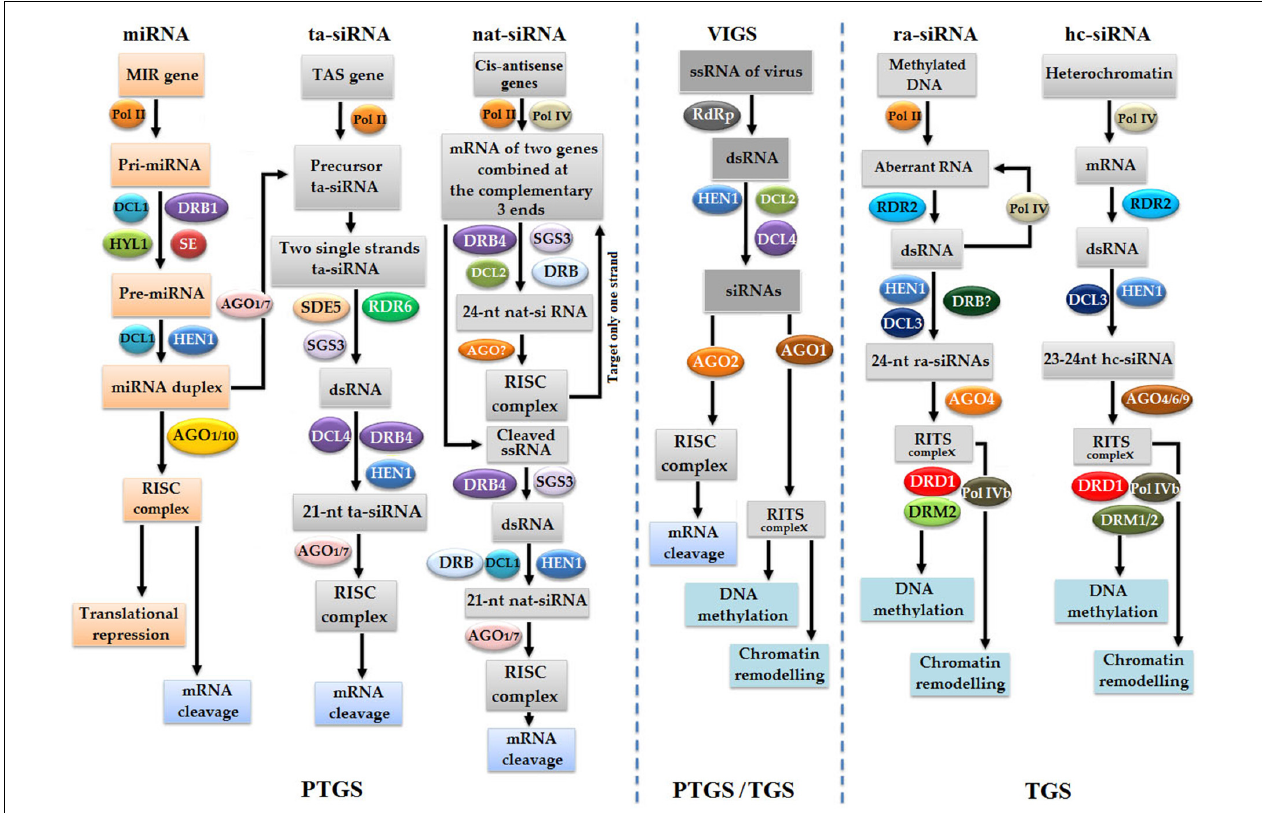
FIGURE 8 | Naturally occurring gene silencing pathways in plants are PTGS gene silencing pathways, such as microRNA (miRNA), transacting siRNA (ta-siRNA), and natural-antisense siRNA (nat-siRNA), whereas TGS gene silencing pathways are repeated-associated siRNA (ra-siRNA) and heterochromatic siRNA (hc-siRNA). Meanwhile, VIGS is considered as artificial silencing methods that occurs via both TGS and PTGS